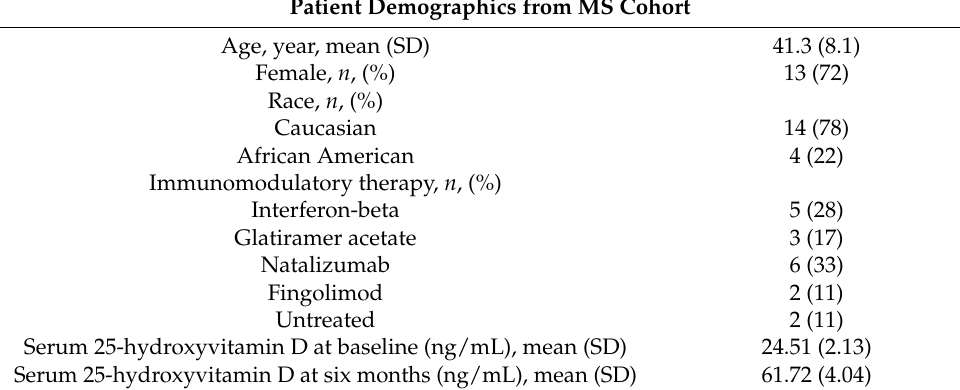
Table 1. Patient